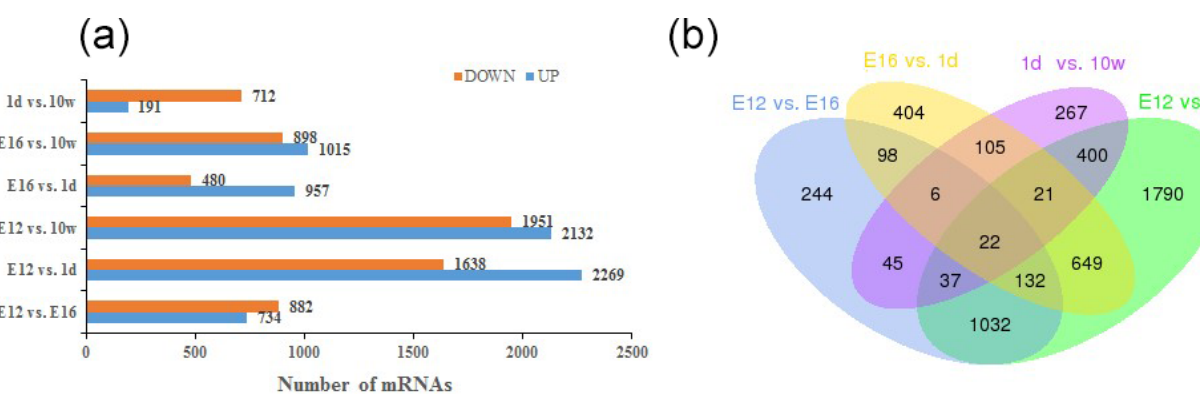
Figure 2. Differentially expressed genes during chicken muscle growth and development at four different stages: (a) numbers of upregulated and downregulated genes in female chickens; (b) Venn diagram of differentially expressed genes in four comparisons of female chickens (E12 vs. E16, E16 vs. 1d, 1d vs. 10w, and E12 vs. 10w).